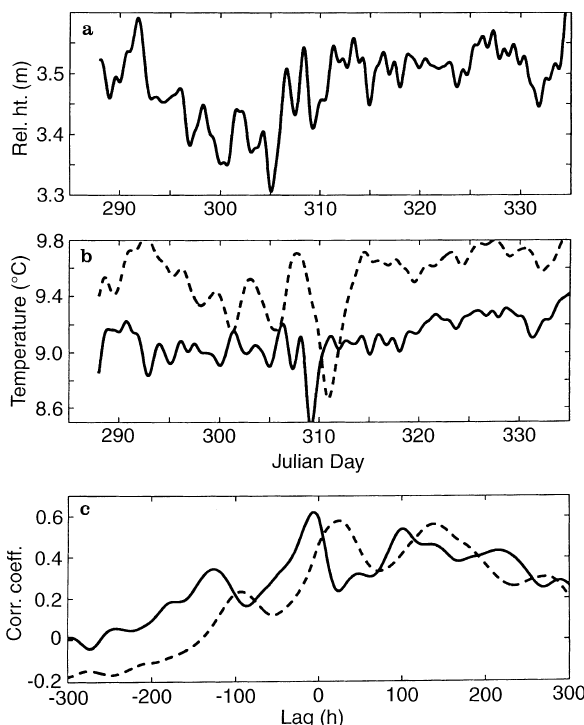
Fig. 9a–c. Time-series of 2-day low passed filtered a sea level (relative), and b temperature at SW (—–) and NE (- - -). The time-lagged correlation coe(cid:129)cients between sea level and SW (—–) and NE (- - -) temperatures are shown in